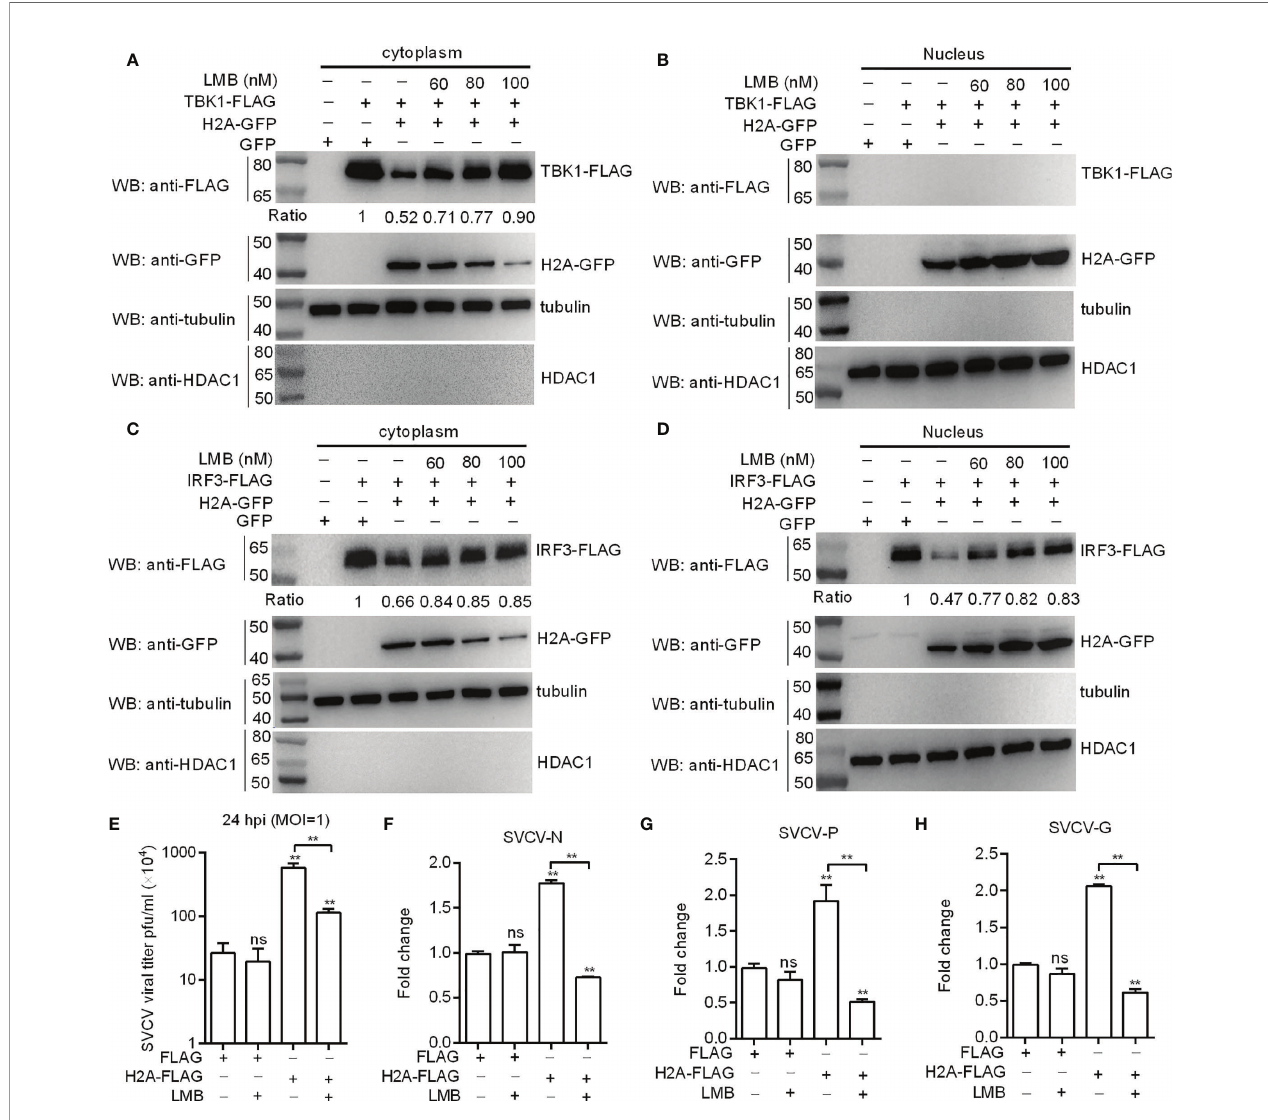
FIGURE 7 | Histone H2A nuclear/cytoplasmic traf fi cking is essential for the negative regulation of histone H2A. (A) Effect of the inhibition of histone H2A nuclear/ cytoplasmic traf fi cking on the protein degradation of cytoplasmic TBK1. (B) Effect of the inhibition of histone H2A nuclear/cytoplasmic traf fi cking on the protein degradation of nuclear TBK1. (C) Effect of the inhibition of histone H2A nuclear/cytoplasmic traf fi cking on the protein degradation of cytoplasmic IRF3. (D) Effect of the inhibition of histone H2A nuclear/cytoplasmic traf fi cking on the protein degradation of nuclear IRF3. For A – D) , EPC cells seeded in 6-well plates were transfected with various indicated plasmids. After 36 h post-transfection, the cells were treated with LMB at the indicated concentration or left untreated. After 12 h, the cells were harvested and used for preparation of nuclear and cytoplasmic extracts. The expression ratio for TBK1 or IRF3 protein was quanti fi ed by Quantity One. (E) Effect of the inhibition of histone H2A nuclear/cytoplasmic traf fi cking on the histone H2A-mediated SVCV replication. (F) Effect of the inhibition of histone H2A nuclear/cytoplasmic traf fi cking on the expression of SVCV-N mediated by histone H2A. (G) Effect of the inhibition of histone H2A nuclear/cytoplasmic traf fi cking on the expression of SVCV-P mediated by histone H2A. (H) Effect of the inhibition of histone H2A nuclear/cytoplasmic traf fi cking on the expression of SVCV-G mediated by histone H2A. For (E – H) , EPC cells seeded in 24-well plates were transfected with p3×FLAG or H2A-FLAG, then treated with LMB or left untreated. After 48 h posttransfection, the cells were infected with SVCV. Another 24 h later, the supernatants of infected cells were collected for the determination of virus titers. The cell pellets of infected cells were collected for qRT-PCR. Data represented means ± SEM (n = 3), and were tested for statistical signi fi cance. ** p < 0.01; ns, not signi fi cant. The asterisk above the error bars indicates statistical signi fi cance using the group microinjected with empty plasmid as the control group. The asterisk above the bracket indicates statistical signi fi cance between the two groups connected by the